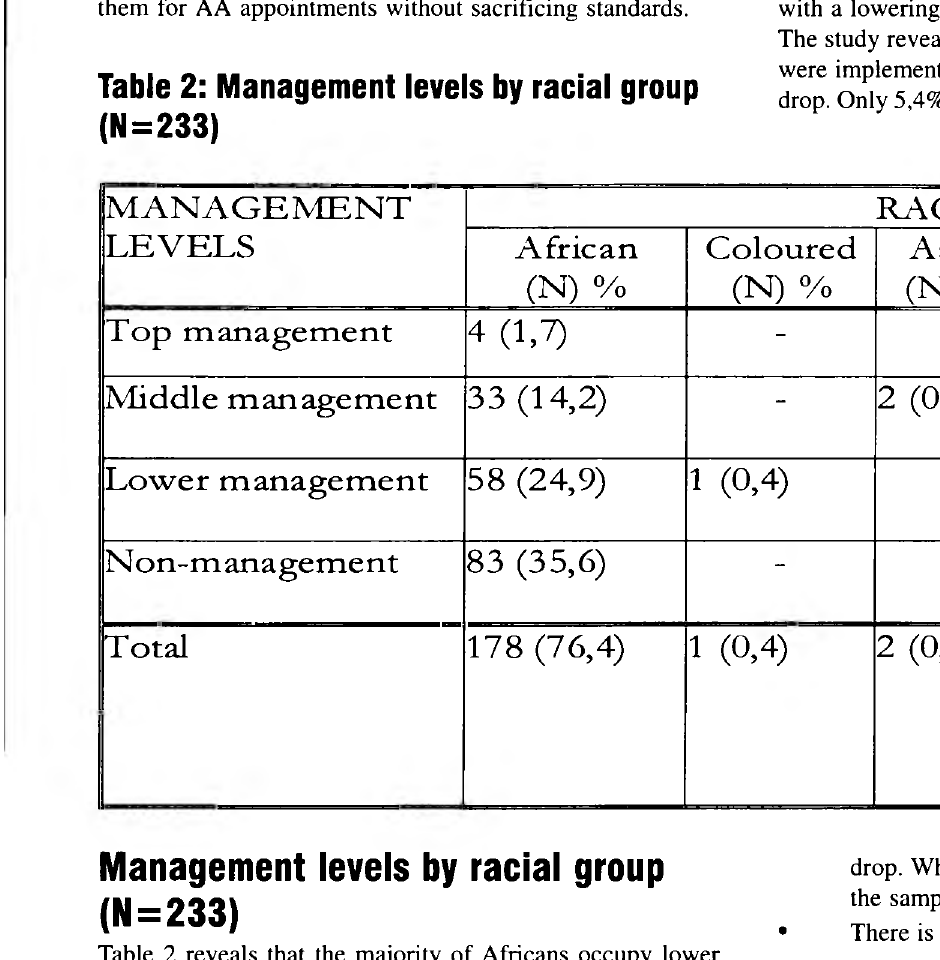
Table 2: Management levels by racial group (N = 2 3 3